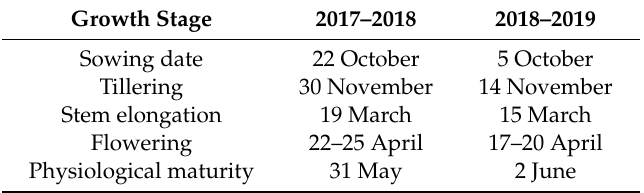
Figure 1. Meteorological data during both cropping seasons: ( a ) monthly precipitation, and ( b ) monthly average temperature. Table 2. The dates of the main developmental stages of winter wheat in two cropping